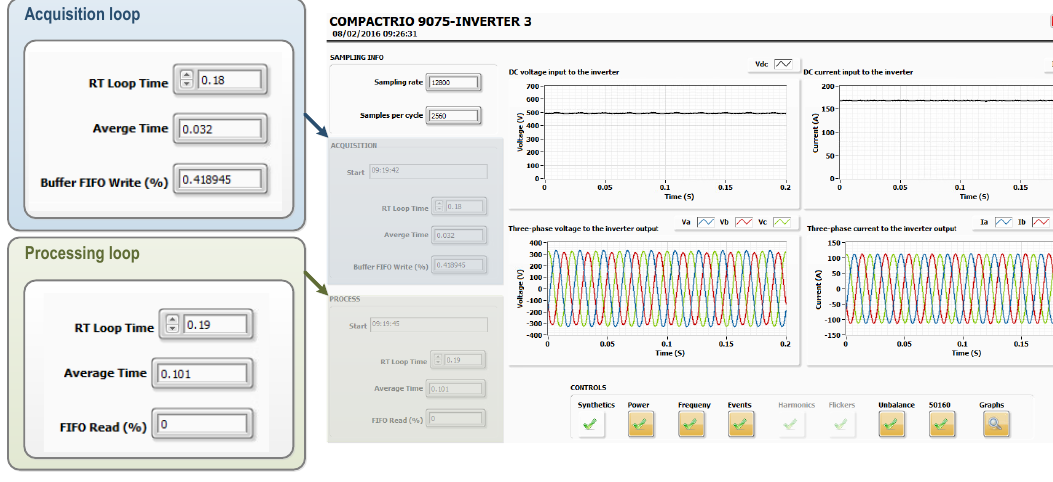
Figure 16. Monitoring PV inverter in